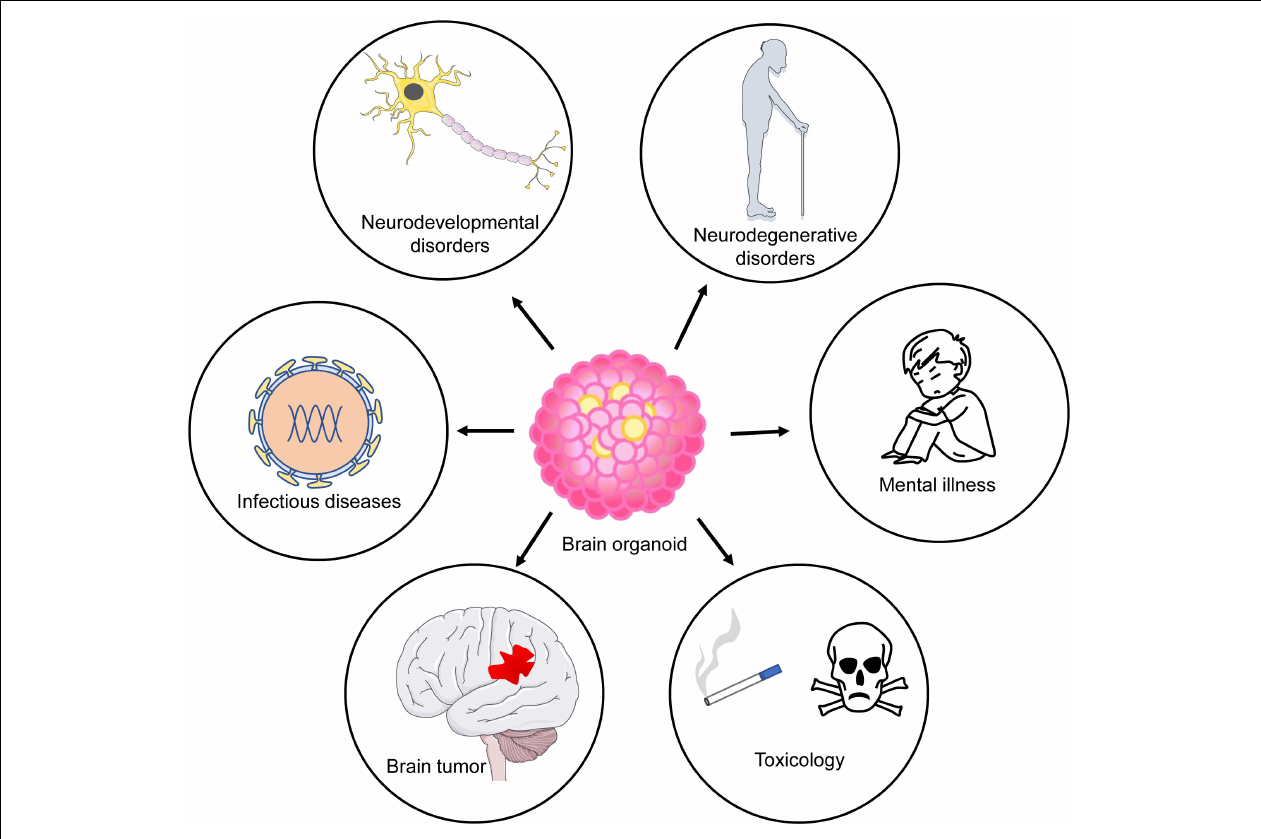
FIGURE 2 | Application of brain organoids as disease models. Brain organoids have been used to model neurodevelopmental and degenerative diseases.